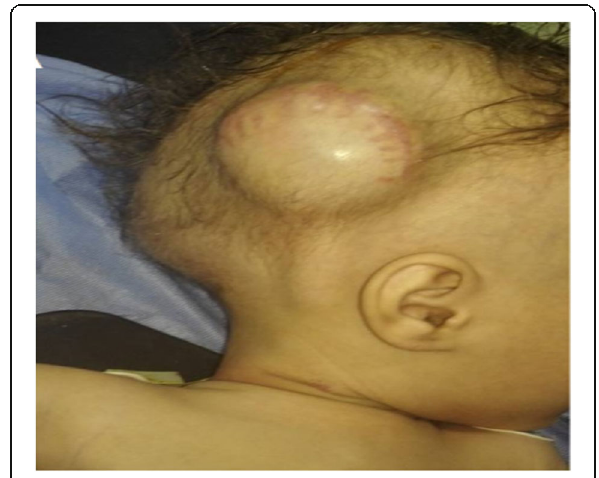
Fig. 4 Photograph of an 8-month-old infant showing CSF collection around the shunt reservoir